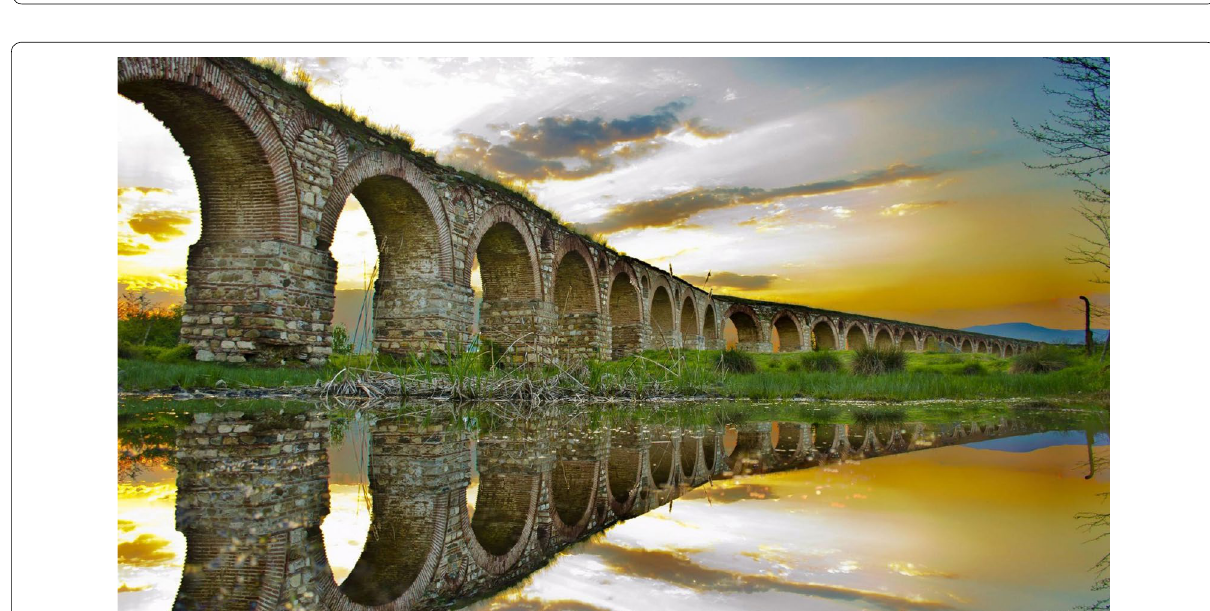
Fig. 3 Roman aqueducts near Rome (from http://www.acqua campa nia.com). Other examples: Dutch mills, salt marshes,